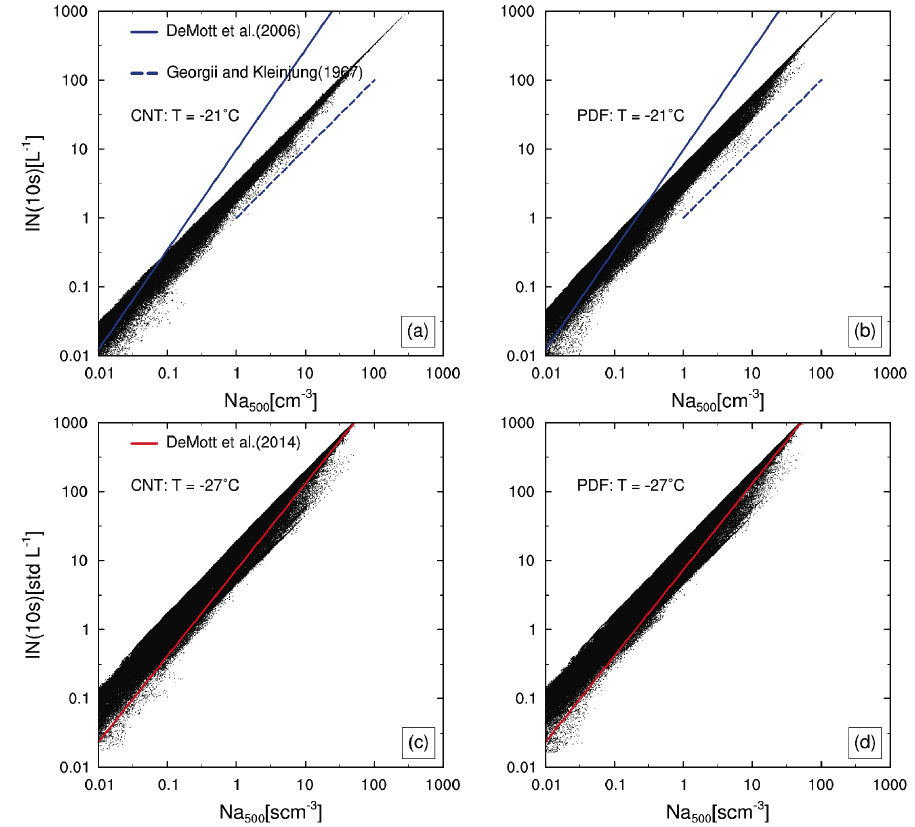
Figure 13. IN(10s) concentrations in the CNT and PDF simulations, displayed as a function of the number concentrations of aerosol particles with a diameter greater than 0.5µm at T = − 21 ◦ C ( a and b ), which is the observed temperature used in the power-law fit to observations (DeMott et al., 2006 (solid blue line); Georgii and Kleinjung 1967 (dashed blue line)) and at T = − 27 ◦ C ( c and d ), which is used for the parameterization proposed by DeMott et al. (2014) (solid red